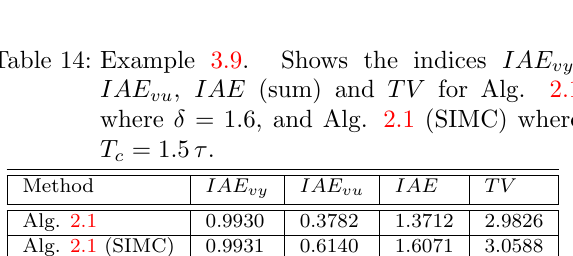
Table 14: Example